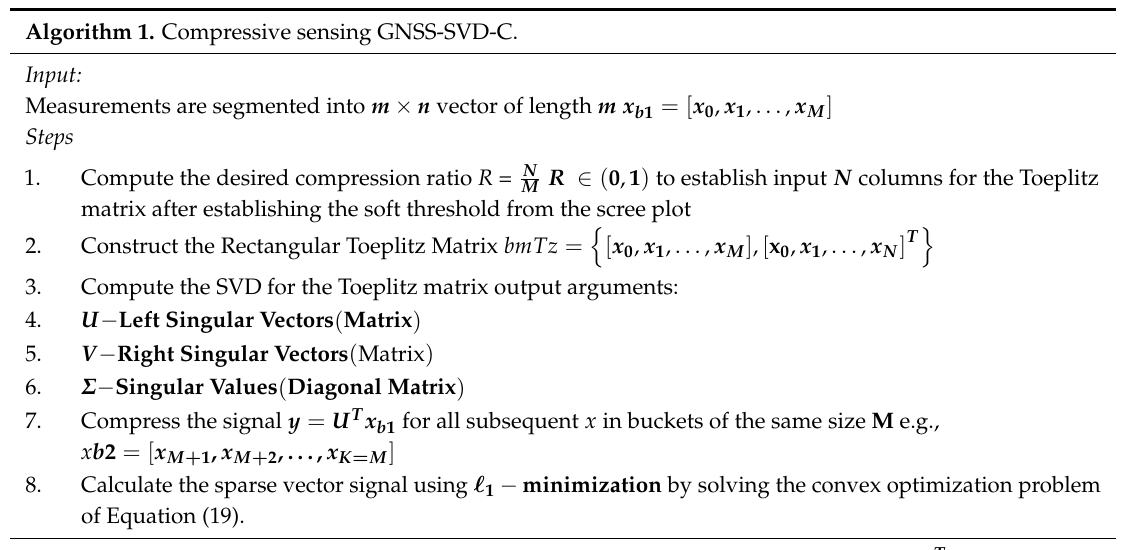
Algorithm 1. Compressive sensing